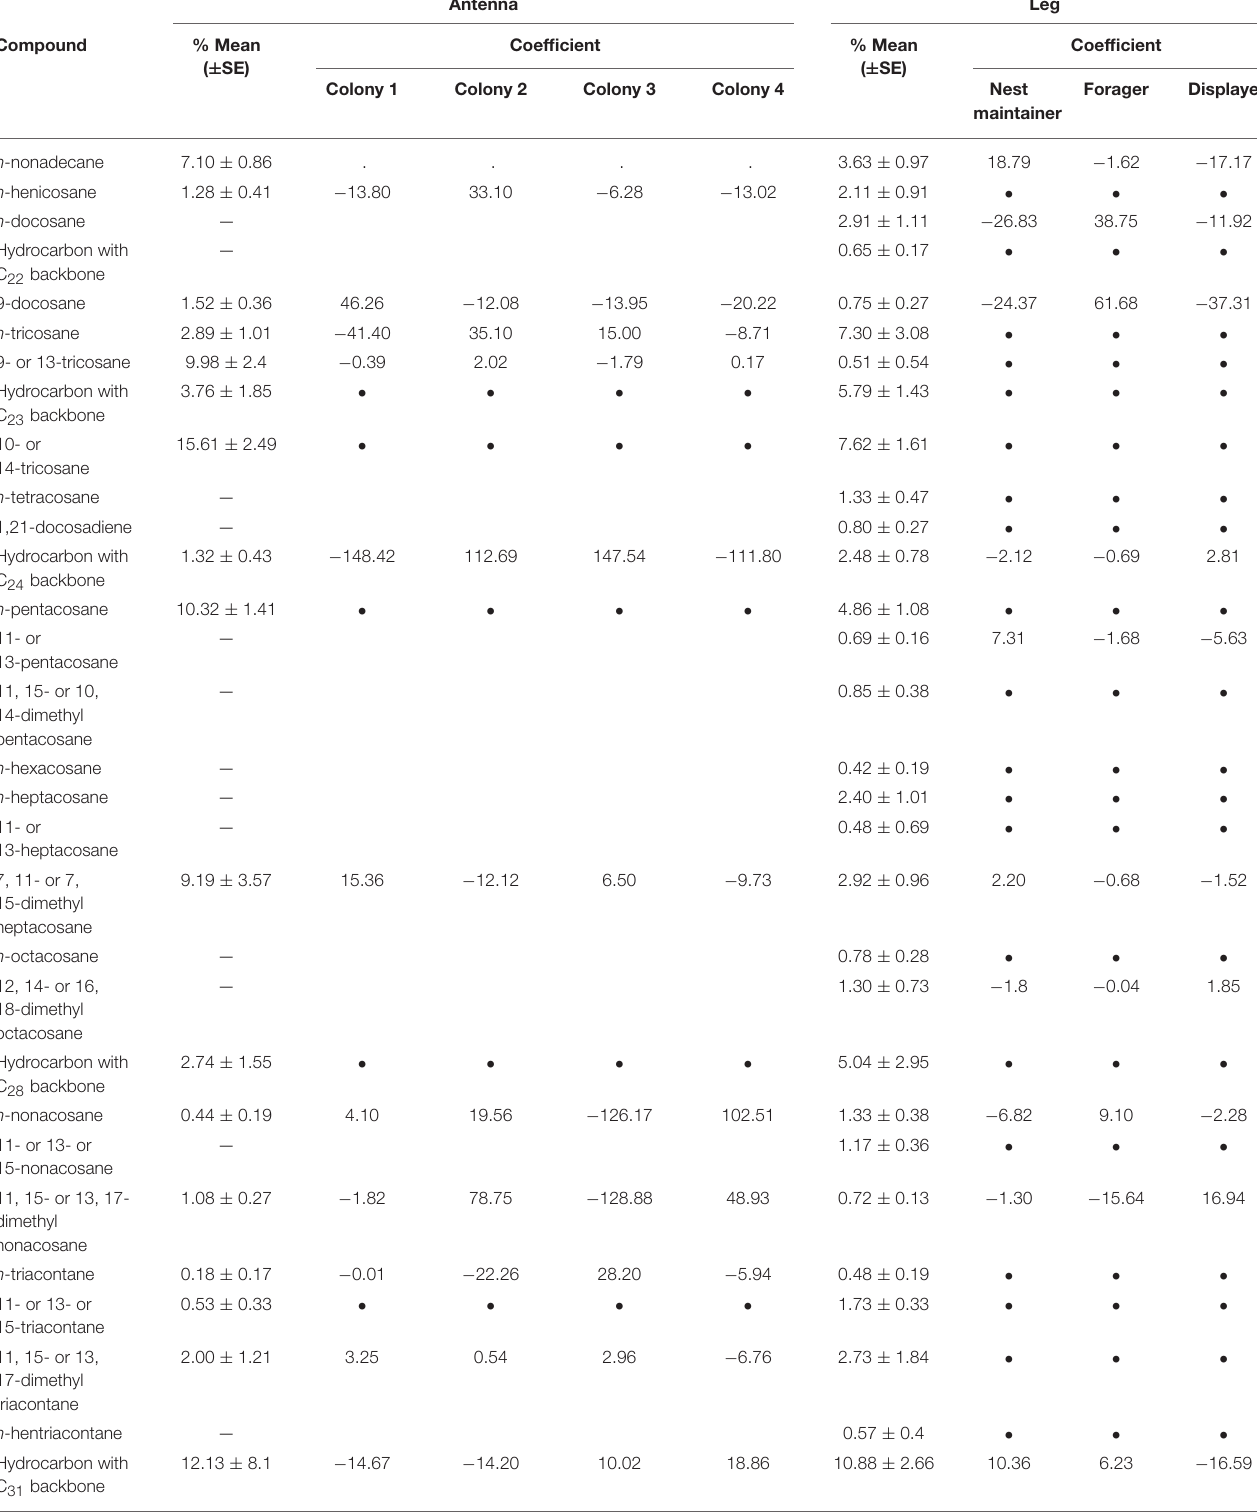
TABLE 1 | GLMNET coefficient of compounds on the antennae and legs of Iridomyrmex purpureus that explain task and nestmate variation.